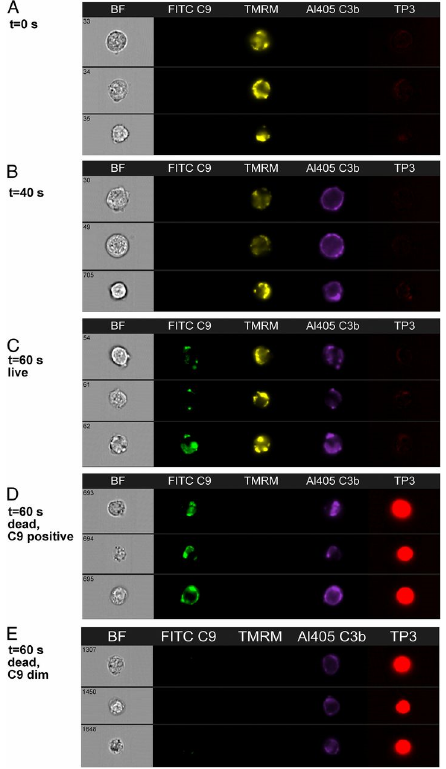
Figure 11. mAb 7D8-Hx mediates CDC of Z138 cells in C9-depleted NHS. Distinct cellular steps in the CDC pathway are illustrated with representative images from an experiment in which Z138 cells were reacted with 7D8-Hx in NHS. ( A ) At zero time, cells are alive (TMRM positive, TP3 negative). ( B ) After 40 s, C3b has deposited, but the cells are still alive, based on the positive TMRM signal and the lack of staining by TP3. ( C , D ) After 60 s, C9 has bound to the cells. Note that both live ( C ) and dead ( D ) (TP3 positive, TMRM negative) C9-positive cells can be seen. ( E ) After 60 s, 8.6% of dead cells are C9 dim [20]. Antibodies 2020 , 9 , x FOR PEER REVIEW